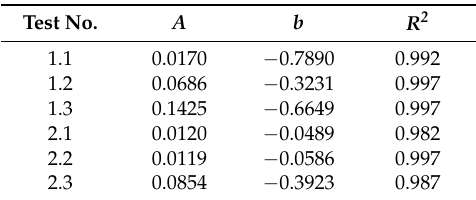
Table 5. A and b coefficients of plastic strain growth.